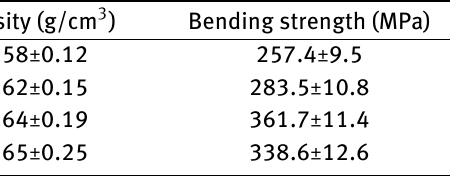
Table 2: Fiber mass fraction, density and bending strength of composites Nano-silica mass fraction